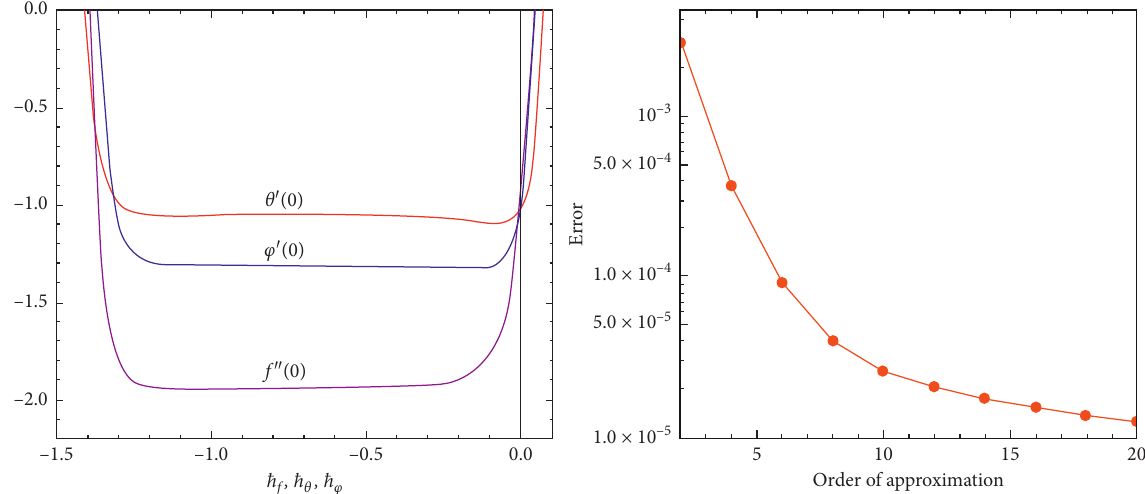
Figure 2: Z -curves (a) and total squared residual error (b) for the 20th HAM 20th order HAM approximation, the optimal values for the convergence-control parameters were found to be